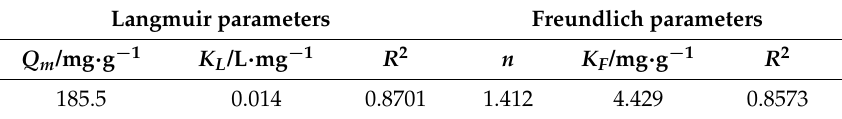
Table 2. Comparison of MyB adsorption capacities in various adsorbents.